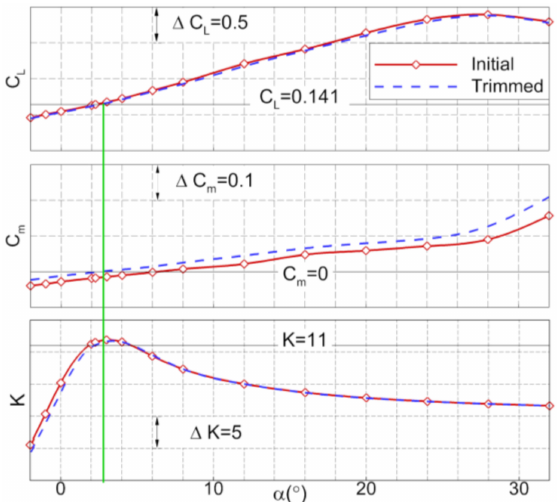
Figure 31. Aerodynamic characteristic of the initial and trimmed configurations. Ma = 0.85, H = 11 km, α = − 2 ◦ ∼ 32 ◦ , ∆ α = 2 ◦